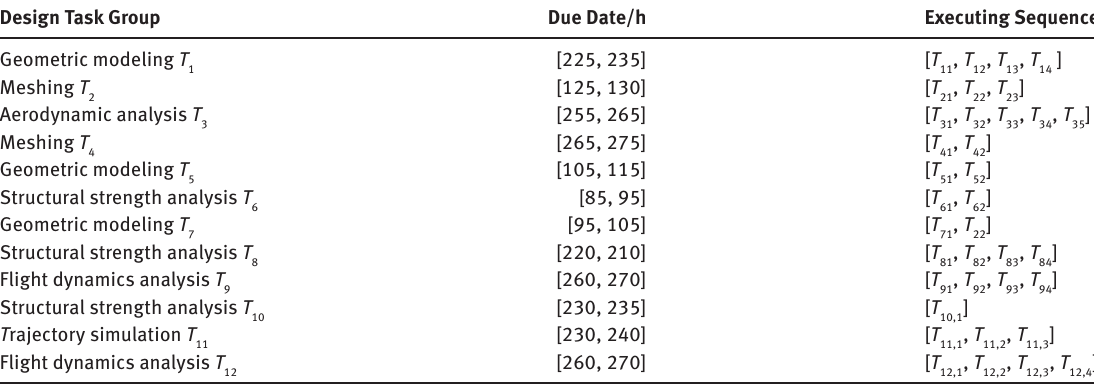
Table 1: Task Attributes.